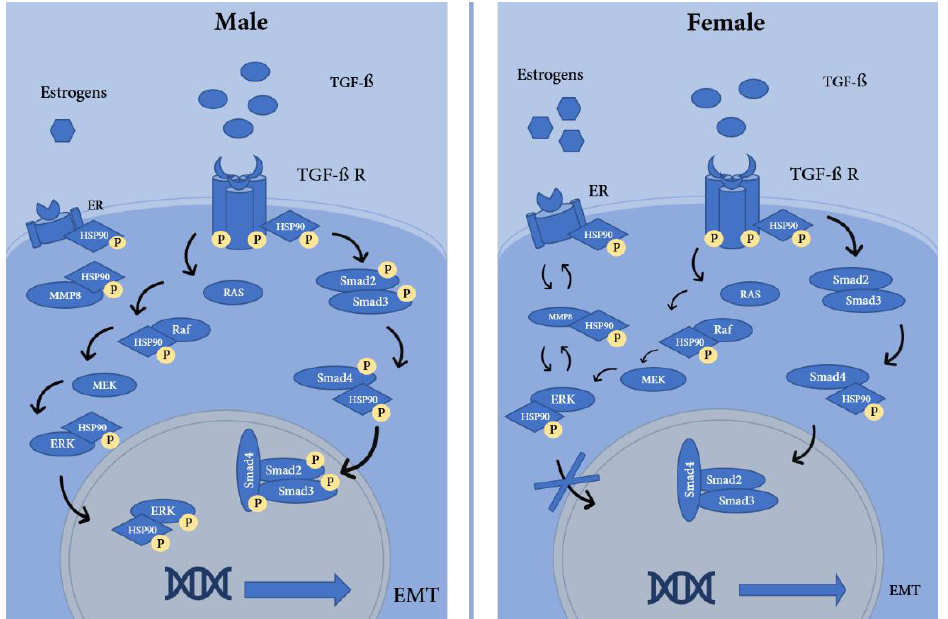
Figure 7. Schematic representation of the proposed gender related differences in TGF- β , SMAD- and non-SMAD-dependent pathways. The non-SMAD dependent pathway involves a large group of kinases, including RAS, MEK, and ERK. ERK is an indirect client protein of HSP90. The SMAD pathway involves different proteins of the same family which translocate to the nucleus. Both SMAD and non-SMAD dependent pathways promote the activation of pro-fibrotic transcription factors leading to the production of collagen, fibrosis and epithelial to mesenchymal transformation (EMT). In females, ERK shows limited activation and phosphorylation of the SMAD proteins, resulting in lessened nuclear transcription and attenuated fibrosis and EMT. Estrogen receptor has a lesser activity profile in men, and thus its interaction with ERK and MMP8 is proposed as a protective mechanism. The phosphorylated form of HSP90 mediates the proper stabilization of profibrotic proteins, thus represents an exciting target for IPF. Additional studies are needed to confirm our results. Immunofluorescence staining of lung sections will be useful in validating the phosphorylation status of Smad2/3 in mouse lungs. Experiments in ovariectomized female mice and castrated male mice would further clarify the role of sex in the development of pulmonary fibrosis, as would comparisons of the current findings with the bleomycin mouse model of